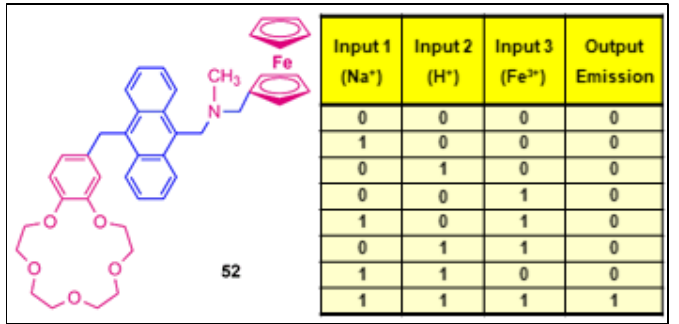
Figure 50. The color-coded design concept of the three-input AND logic gate 52 for Na + (15-crown-5 receptor1), pH (tertiary amine receptor2), and pE (ferrocene redox unit) and the corresponding truth table [154].